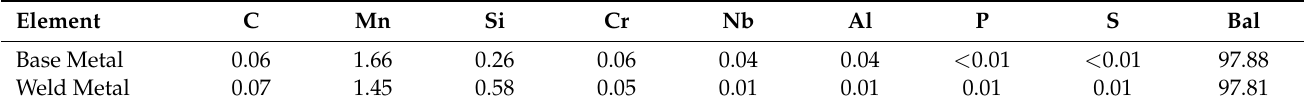
Table 1. Composition of the base metal and weld metal. Bal is